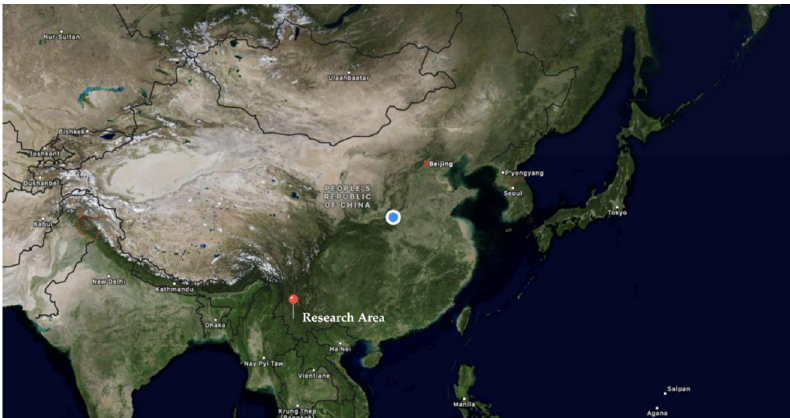
Figure 1. The location of the research area.